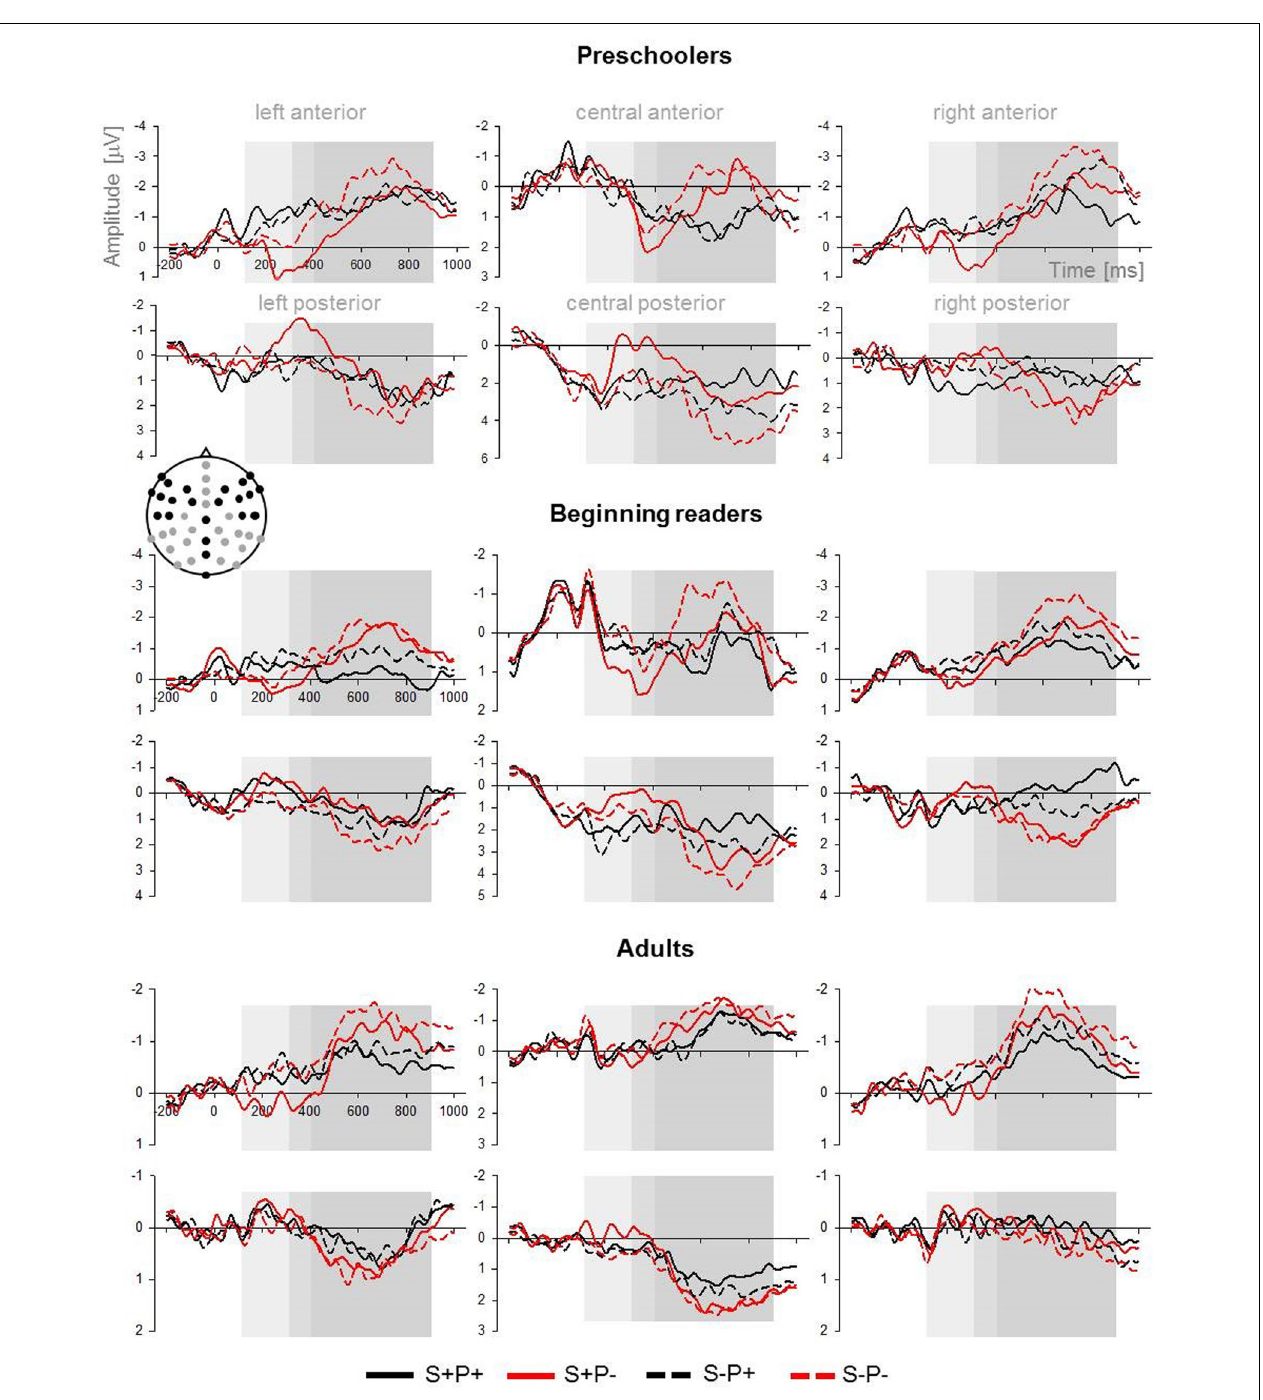
FIGURE 3 | Mean ERPs over the lateral (left and right) and central and over the anterior and posterior ROIs for each group. Black and gray dots on the head montage indicate the electrode positions that contributed to the ROIs. The three time windows analyzed in greater detail are highlighted in gray.